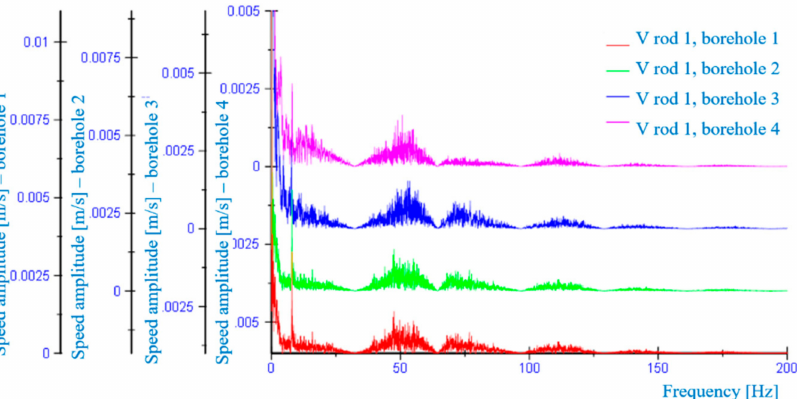
Figure 15. Comparison of the frequency distribution for the first drill rod and four consecutive test boreholes on stand No.